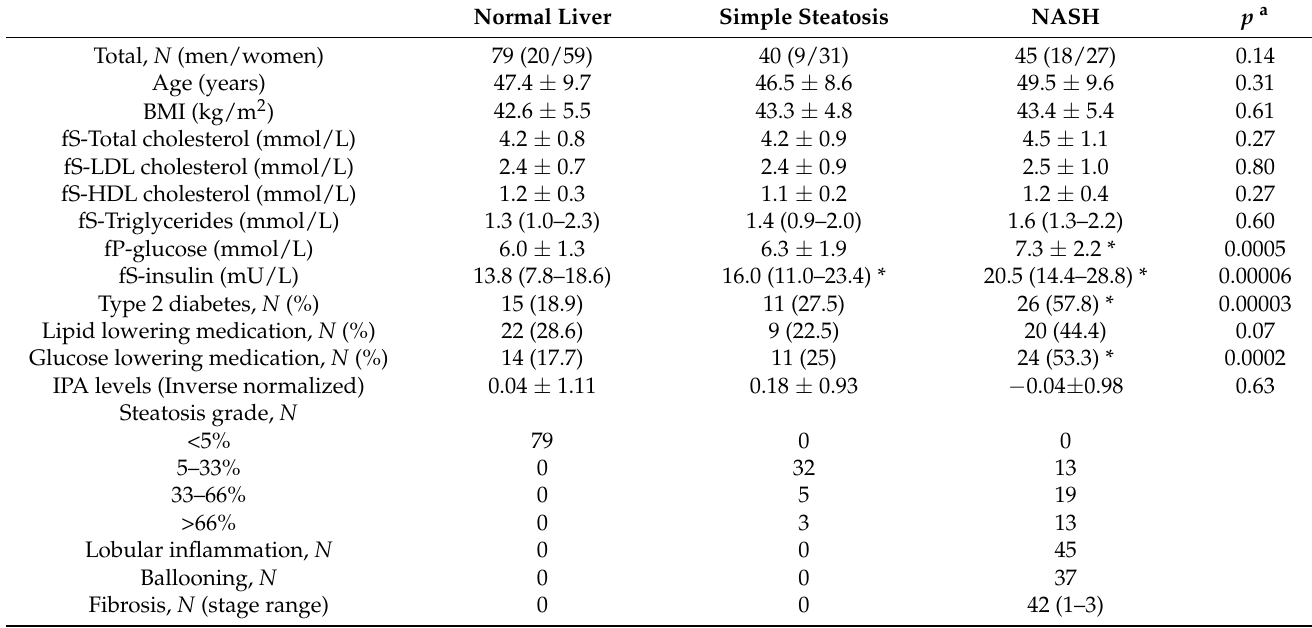
Table 1. Clinical characteristics and liver histology of study participants according to histological liver phenotype. Normal Liver Simple Steatosis